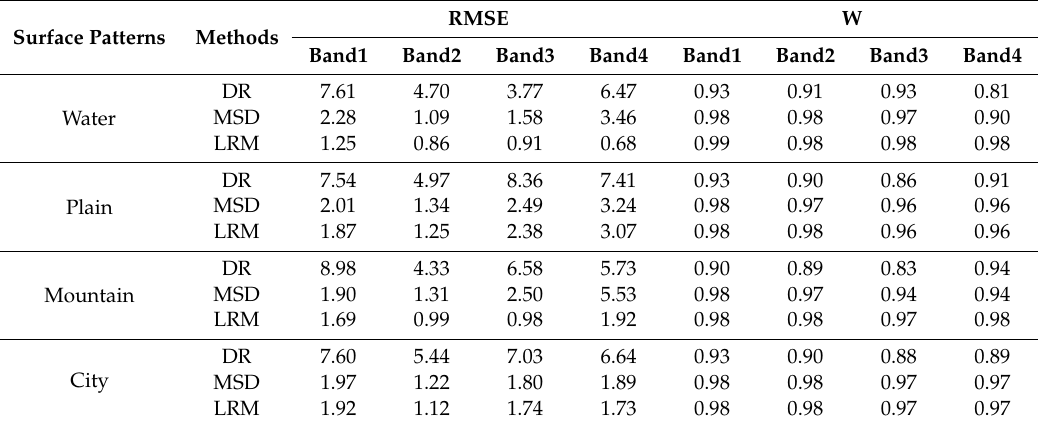
Table 1. Accuracy of cloud removal for a small patch (10 × 10 pixels) assumed cloud cover over representative surface patterns in the TM image of